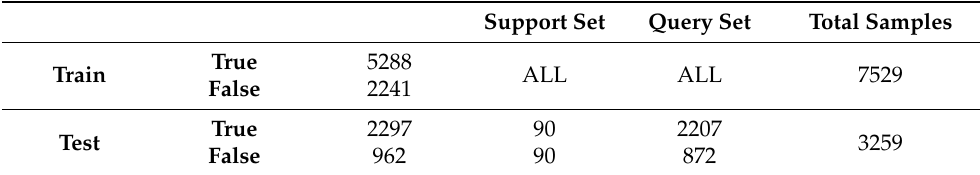
Table 4. Support-Query